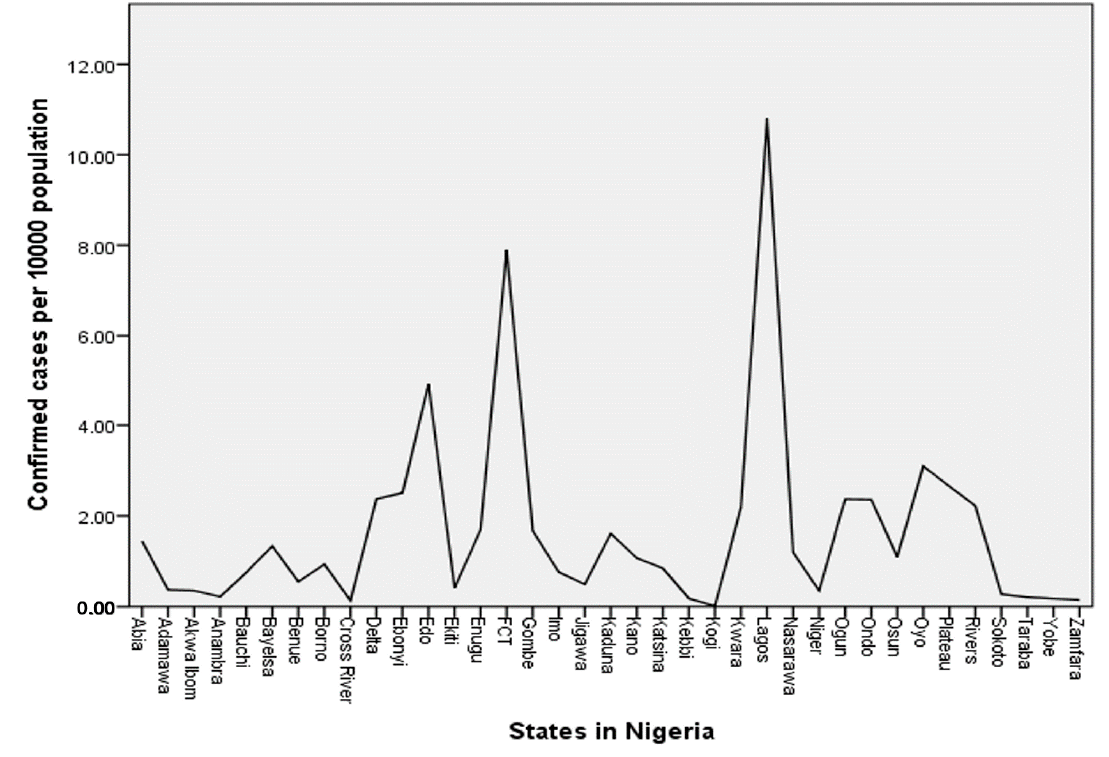
Figure 1. COVID-19 confirmed rates per 10,000 population of each state and the FCT in Nigeria.